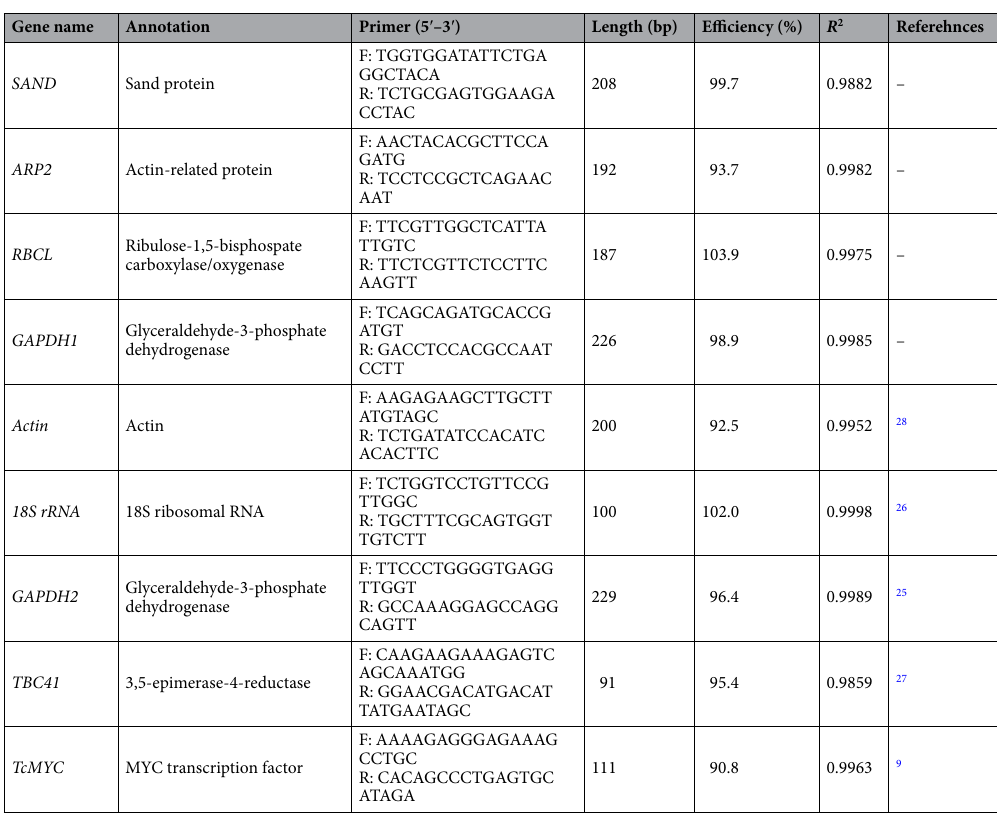
Table 1. Primer and amplification efficiency (E) of candidate reference genes obtained by qRT-PCR.